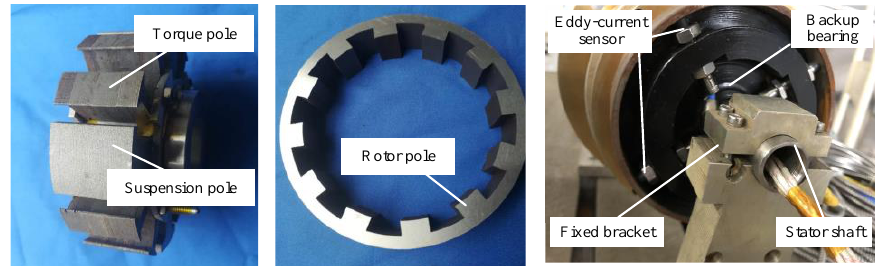
Figure 13. Optimized prototype stator, rotor structure and its overall diagram.